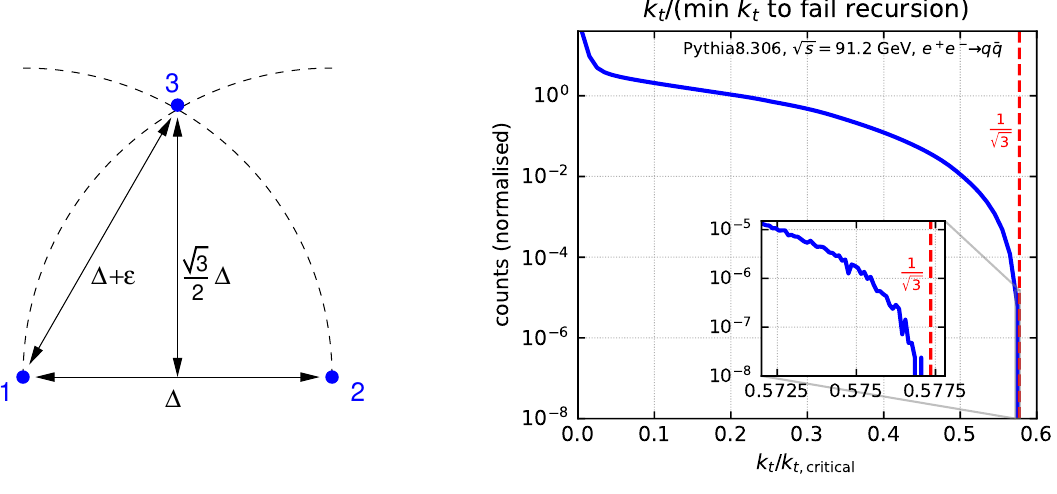
Figure 10. Left: sketch of a 3 particle system where angles between particles become smaller after clustering. Right: number of events as a function of the ratio between the k the critical k as defined in the text. Since the number of events drops at k t this plot illustrates that the Lund multiplicity is equivalent to counting the Cambridge clusterings with a k above a given k t t, cut